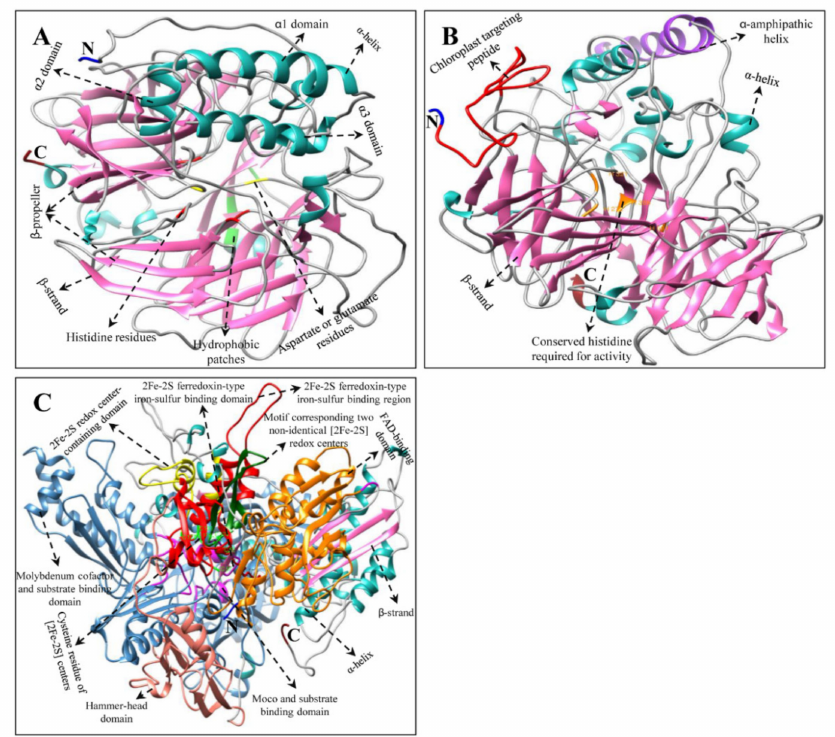
Figure 6. Tertiary structure of AP genes of H. moellendorffii. ( A ) HmCCD, ( B ) HmNCED, and ( C ) HmAO structures were created by using Chimera software (version 1.14) [62]. The amino (NH 2 ), carboxyl (COOH) termini, α -helices, and β -strands are shown in blue, red, green, and pink, respectively. Multiple alignments of each AP gene are shown in Figure